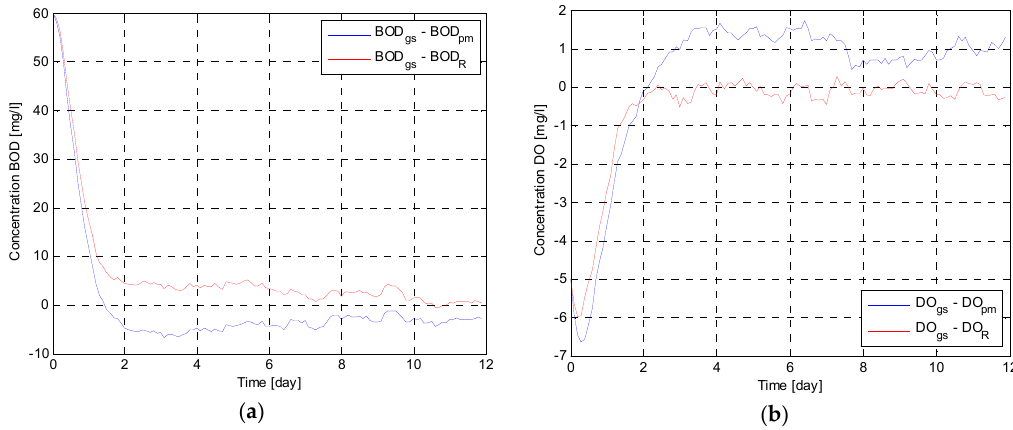
Figure 7. Distribution of BOD ( a ) and DO ( b ) signals errors resulting from inaccurately selected model parameters (different extortions).